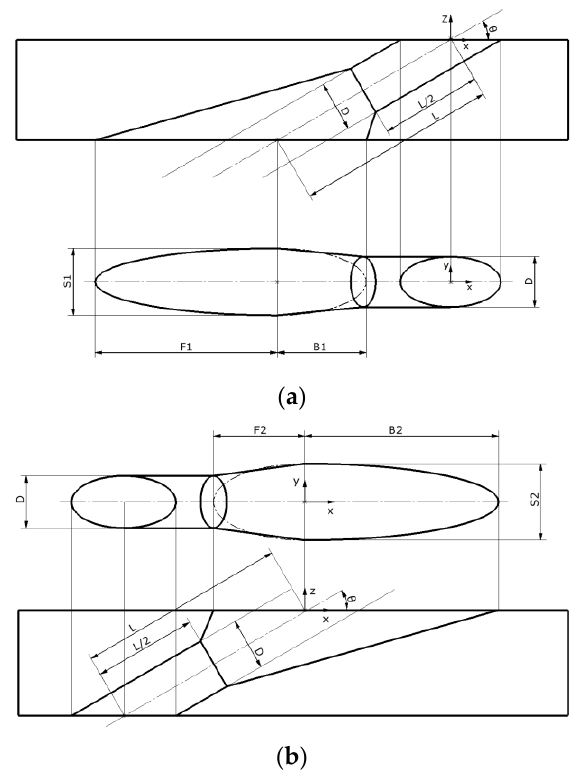
Table 1. Geometric parameters of two-head flared hole.